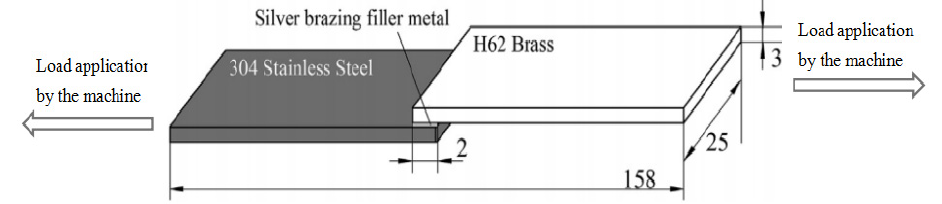
Figure 1. Brazing specimens for shear strength test.